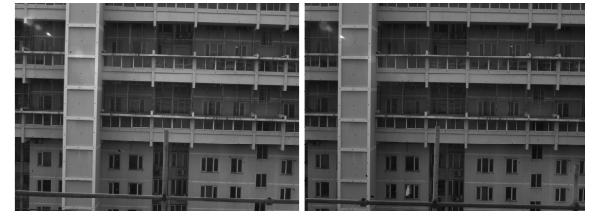
Figure 3. Stereo images that capture the control points.